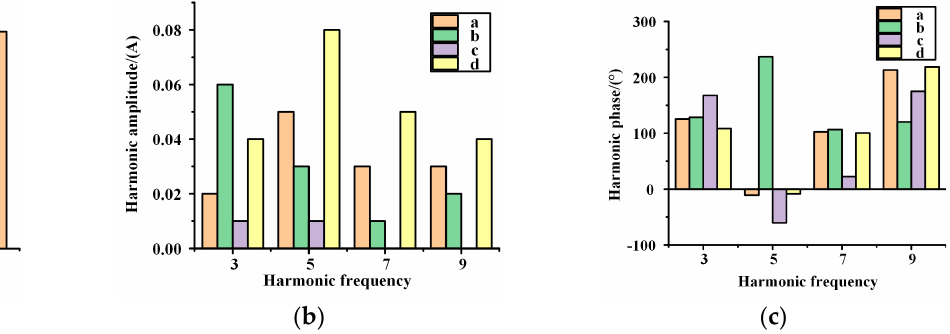
Figure 2. V-I trajectory diagram of similar load for ( a ) co ff ee maker, ( b ) hair dryer, ( c ) incandescent light bulb, ( d ) ke tt le.